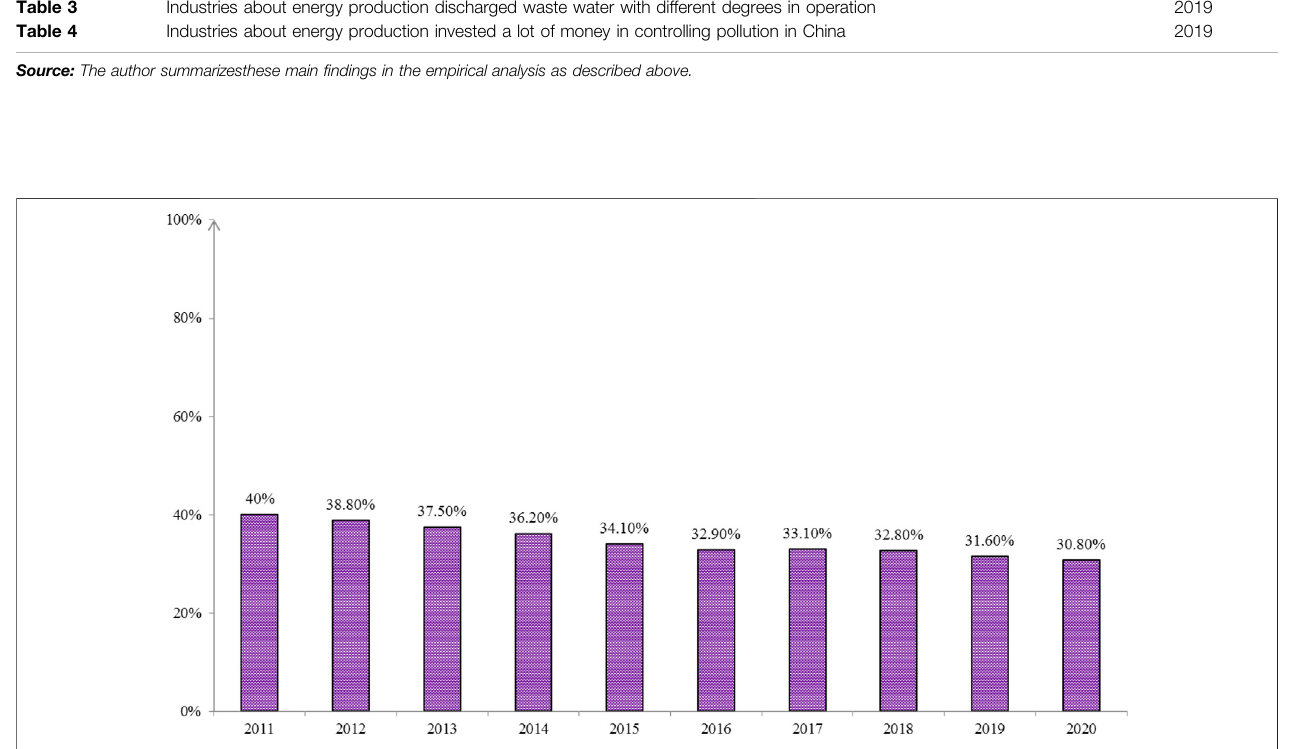
Frontiers in Environmental Science |